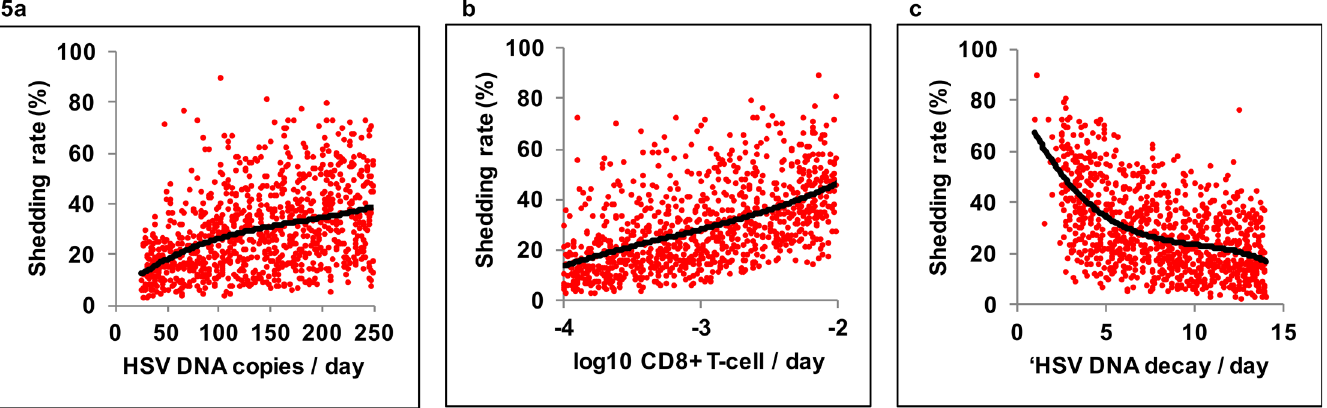
Fig 5. Individual determinants of increased HSV-2 shedding rate. Critical model predictors of shedding rate in 10-year simulations with 1000 parameter sets. Curves in all panels indicate best fit with a polynomial model while dots are single simulations. (A) HSV-2 release rate from ganglia to the genital tract (R 2 = 0.17), (B) Genital T-cell decay rate (R 2 = 0.29), (C) HSV-2 DNA clearance rate (R 2 = 0.30), predict shedding rate to various degrees. Genital T-cell levels in the model are intended as a surrogate measure of cytolytic immune